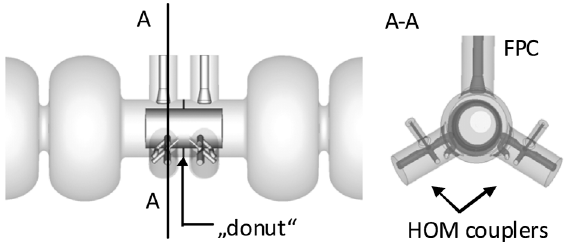
FIG. 1. FPC and HOM couplers in two mirrored coaxial coupling devices placed between two cavities (left) and cross section of the coupling device